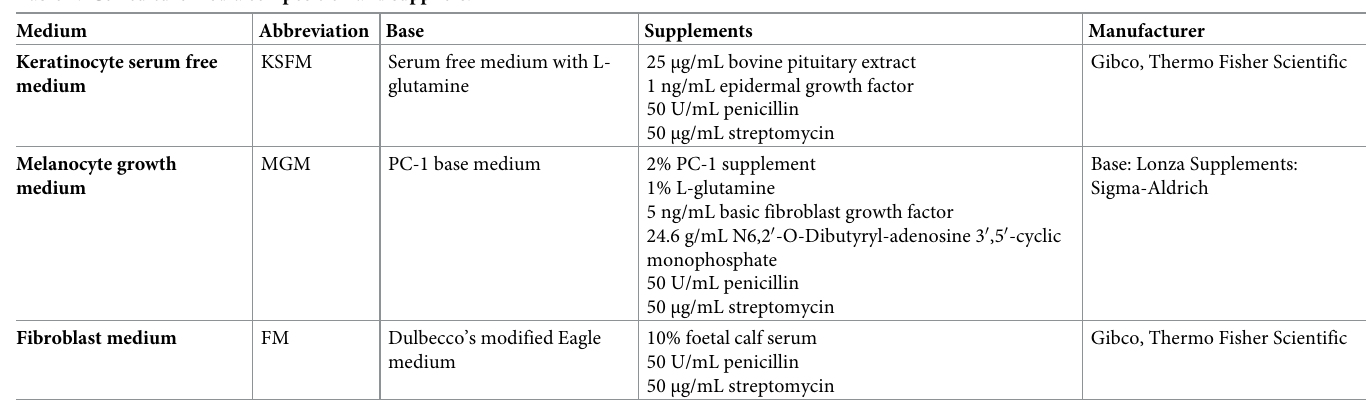
Table 1. Cell culture media composition and